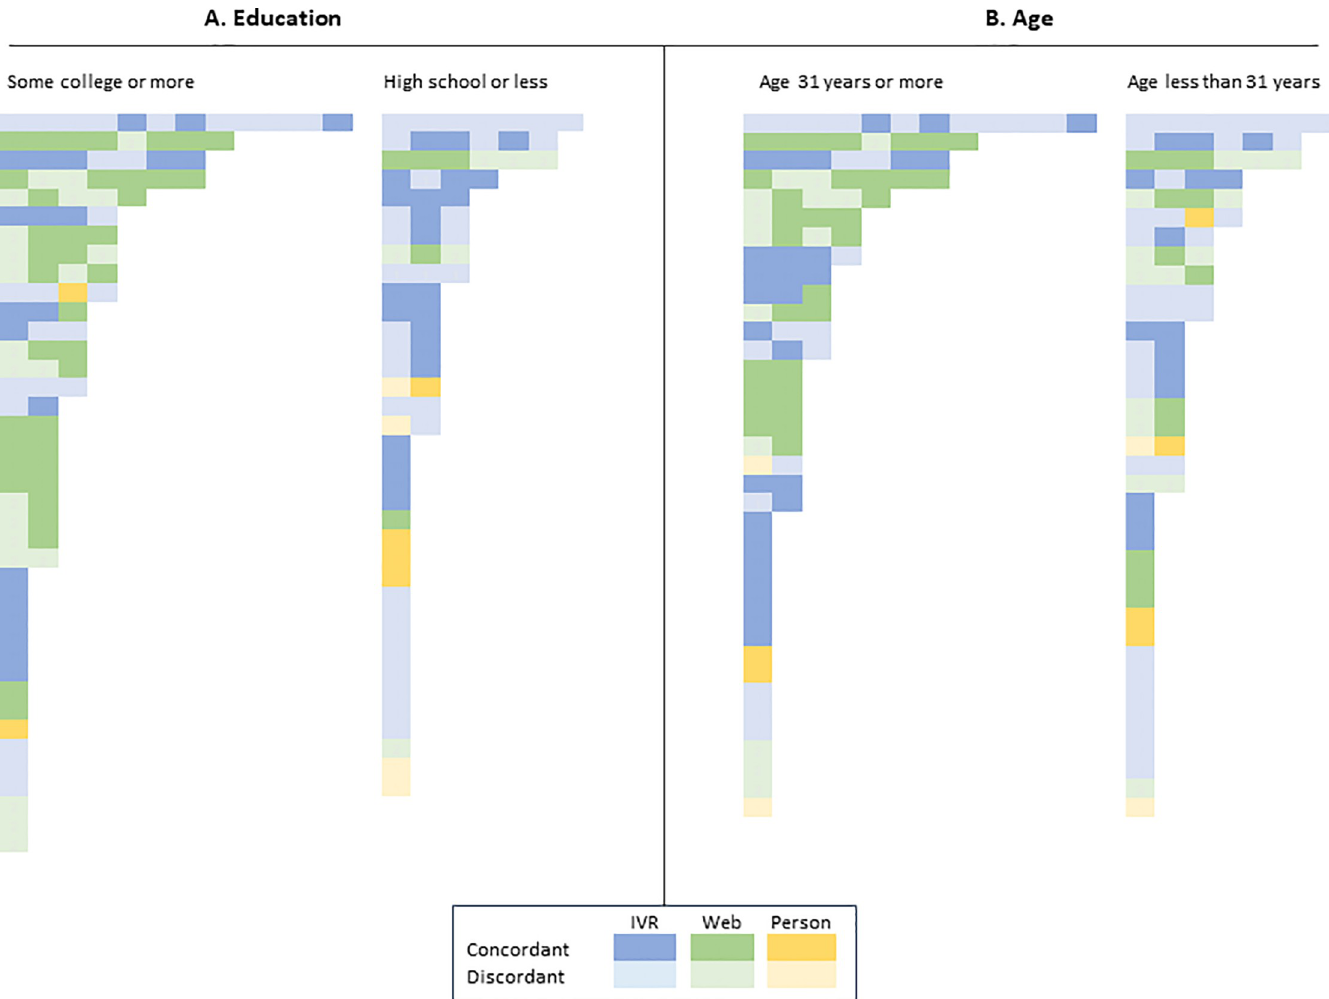
Fig 2. Distribution of visits per mother, stratified by (A) level of maternal education or (B) age. Education: any college vs. high school or less; age: less than vs. equal to or greater than the median (31 years). Each square represents one HCP illness visit. Each row within a column represents a mother. Within each column, mothers are sorted by total number of visits (highest to lowest). Visits within each mother are sorted by time, with the earliest visit on the left-hand side of the column. Visits are classified both by type of survey used after the visit (IVR: blue; email: green; person: yellow) and by concordance (concordant: dark; discordant: